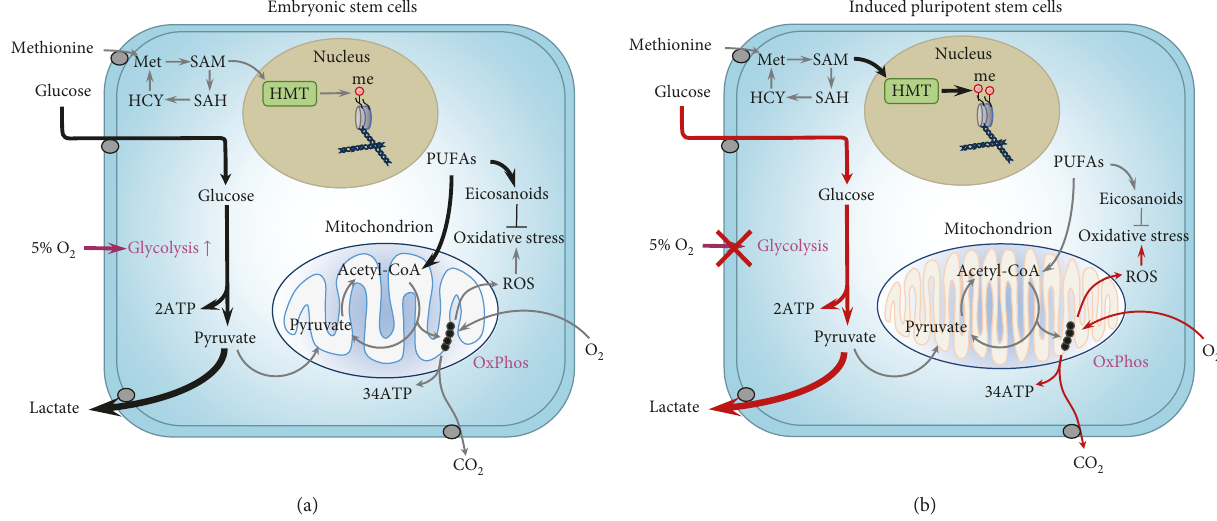
Figure 1: Metabolic di ff erences between embryonic stem cells (ESC) (a) and induced pluripotent stem cells (iPSC) (b). Glycolytic rate, glucose consumption, and lactate production are altered in iPSC by both the retention of somatic cell metabolic memory and the acquisition of aberrant metabolic characteristics [87, 88]. Signi fi cantly, due to the retention of metabolic memory or the acquisition of metabolic aberrations, the capacity for iPSC to modulate glycolysis in response to changes in oxygen (O ) is impaired. In contrast, this 2 oxygen response, whereby glucose to lactate fl ux is signi fi cantly increased under physiological (5%) oxygen conditions relative to that under atmospheric (20%) oxygen, is well characterised in both ESC [28, 29] and the blastocyst [105]. Levels of polyunsaturated fatty acids (PUFAs), including arachidonic acid, linoleic acid, docosapentaenoic acid, and adrenic acid, are lower in iPSC than in ESC [7]. PUFAs regulate oxidative metabolism by undergoing beta-oxidation to produce acetyl-CoA and can be converted to eicosanoids, which can mitigate oxidative stress, caused by reactive oxygen species (ROS) as a result of oxidative phosphorylation (OxPhos), through the activation of peroxisome proliferator-activated receptor gamma (PPAR γ ) [100, 101]. Eicosanoids also plausibly regulate mitochondrial biogenesis and function though the action of PPAR γ recruiting PPAR γ coactivator 1- α (PGC-1 α ) [102]. Levels of the methyl donor and cofactor S-adenosyl methionine (SAM) are higher in iPSC than in ESC [7], resulting in a greater methylation (me) of histones in iPSC through the action of histone methyltransferases (HMT). SAM is produced from methionine (Met) and, when demethylated, results in S- adenosyl-L-homocysteine (SAH) which is hydrolysed to homocysteine (HCY) and converted into methionine. Mitochondria in iPSC morphologically resemble both those of ESC and somatic cells [9]. Mitochondrial activity in iPSC is a ff ected by the culture conditions under which they are reprogrammed, whereby iPSC derived under physiological oxygen possess mitochondria that are less active and more ESC-like when compared to those of iPSC derived under atmospheric oxygen [88]. It has also been shown that iPSC acquire and accumulate mitochondrial DNA (mtDNA) mutations [90], with the frequency of these mutations increasing with parental somatic cell age [93]; however, the degree to which these mutations impact mitochondrial metabolism and activity in iPSC is unknown. However, in somatic cells, mtDNA mutations can contribute not only to mitochondrial dysfunction [95] but also to cellular senescence and telomere shortening [96]. Thick arrows indicate increased fl ux/activity. Red arrows indicate pathways a ff ected by the retention of somatic cell memory or acquisition of metabolic aberrations in